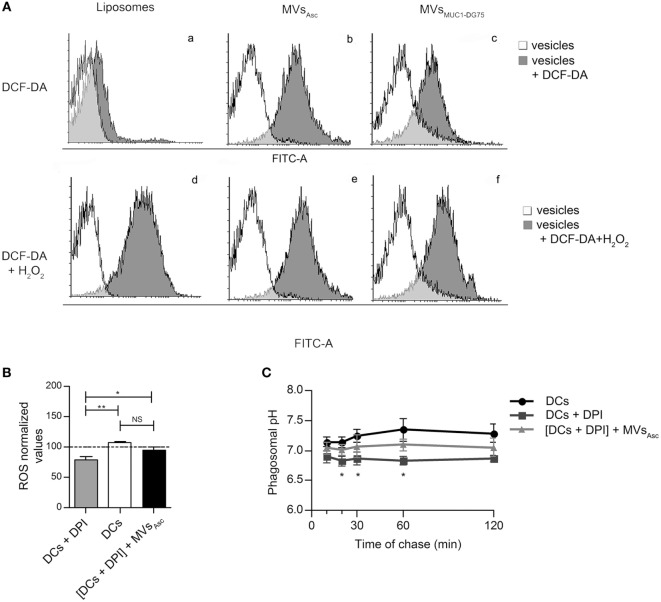
Tumor microvesicles (MVs) are source of radical species and modulate phagosomal alkalinization. (A) The presence of reactive oxygen species (ROS) molecules in Liposomes (a, d), MVsAsc (b, e), and MVsMUC1-DG75 (c, f) was analyzed used DCF-DA (a–c) and DCF-DA + H2O2 as positive control (d–f). Results are plotted as graph; y-axis: event count; x-axis: Log-FITC-A (from 0 to 105). White histograms are referred to the background fluorescence of Liposomes and MVs samples, gray histograms represent Liposomes and MVs treated with DCF-DA (a–c) or with DCF-DA + H2O2 (d–f). The mean fluorescence intensity for untreated sample, DCF-DA-treated and DCF-DA + H2O2 samples were, respectively: MFI 2, 18, 229 for Liposomes; MFI 5, 381, 481 for MVsAsc; MFI 9, 75, 212 for MVsMUC1-DG75. (B) ROS species measurement in DPI-treated DCs following MVsAsc pulsing. MVsAsc uptake (black histogram) restored ROS levels in DPI-treated DCs (gray histogram) similarly to unpulsed DCs (withe histogram). ROS levels are plotted as arbitrary units of three independent experiments (three donors). ROS level in unpulsed DCs at time 0 of chase correspond to 100 arbitrary units. *p < 0.05; **p < 0.01. (C) Phagosomal pH measurement in DCs in the presence of DPI, without or with MVsAsc pulsing. Diphenyleneiodonium chloride (DPI) treatment decreased pH compared to untreated DCs (black line, squared vs. black line, dotted). In MVs pulsed DPI-treated DCs (gray line, triangle) phagosomal pH was partially restored. The difference between DPI-treated DCs (black line, squared) and MVs pulsed DPI-treated DCs (gray line, triangle) is statistically significant from 20 to 60 min of chase (*p < 0.05). Values are mean ± SD of three independent experiments.